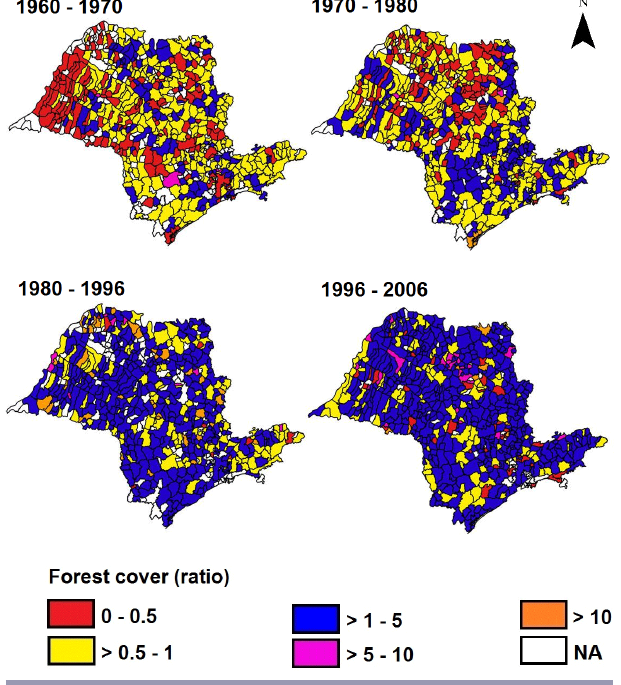
Fig. 3 . Forest cover ratio at the municipality-scale across São Paulo between 1960 and 2006. Municipality boundaries are shown in grey. Forest cover ratio was calculated by dividing forest cover values in one census by forest cover values of the previous census (e.g., FC in 1970/FC in 1960). Ratio values greater than 1 indicate that forest cover increased over the census interval and ratio values lower than 1 indicate that forest cover decreased. (NA) Missing